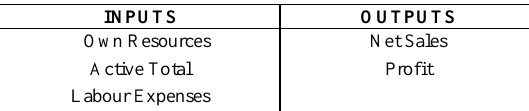
Table 3. Input and output variables